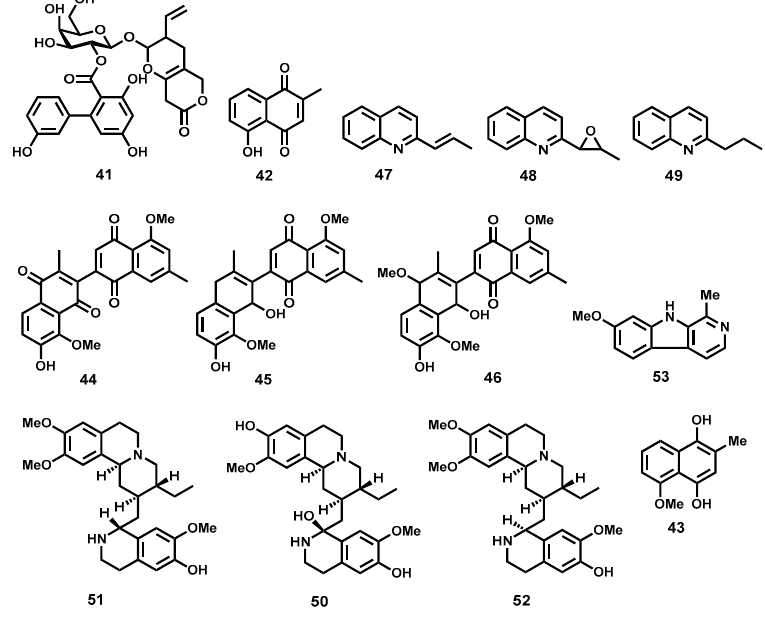
Figure 8. Antileishmanial iridoid, naphtoquinone, quinolines, and alkaloids.